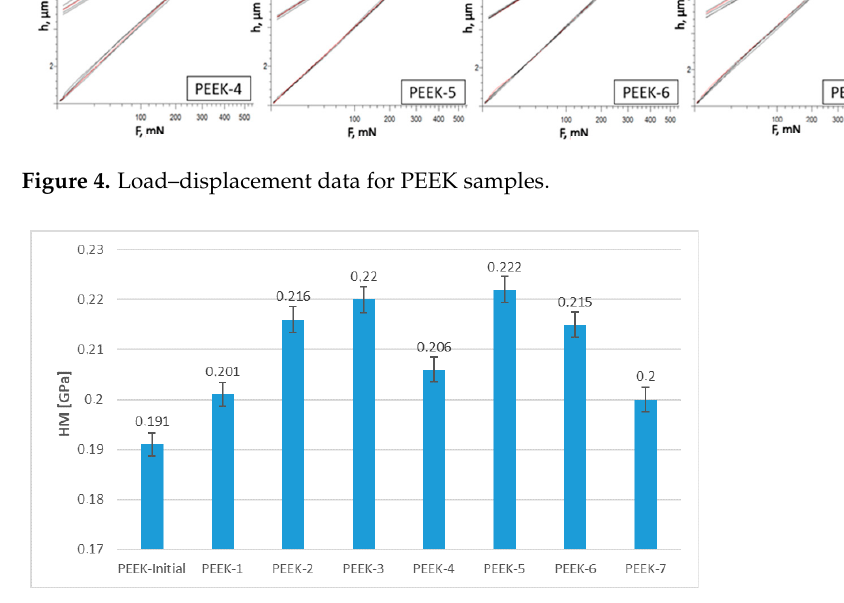
Figure 5. Variations of PEEK microhardness.